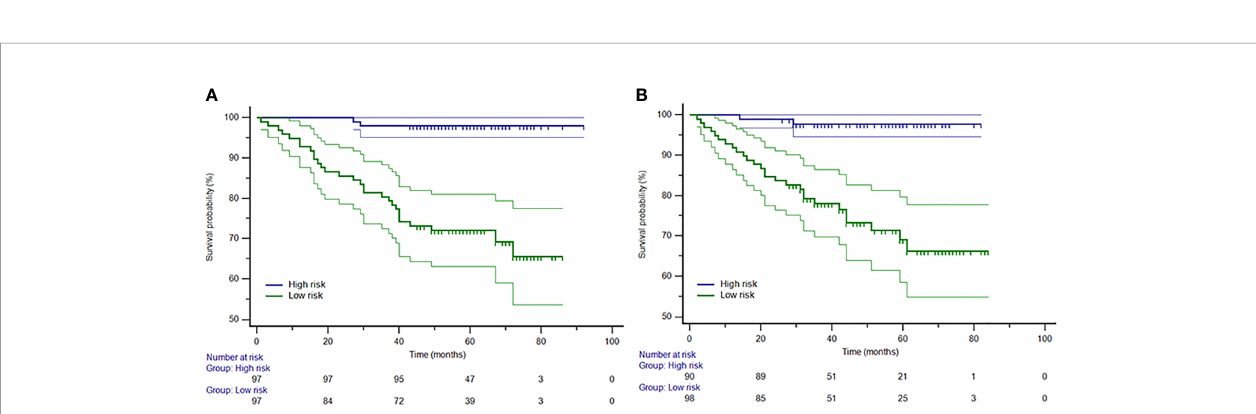
FIGURE 3 | The Kaplan-Meier curves for patients in low-risk and high-risk groups in the training (A) and test (B) cohorts. The median Rad-score was − 0.04481, which was applied as a cutoff that strati fi ed patients into the high-risk group (Rad-score ≥ − 0.04481) and the low-risk group (Rad-score < −